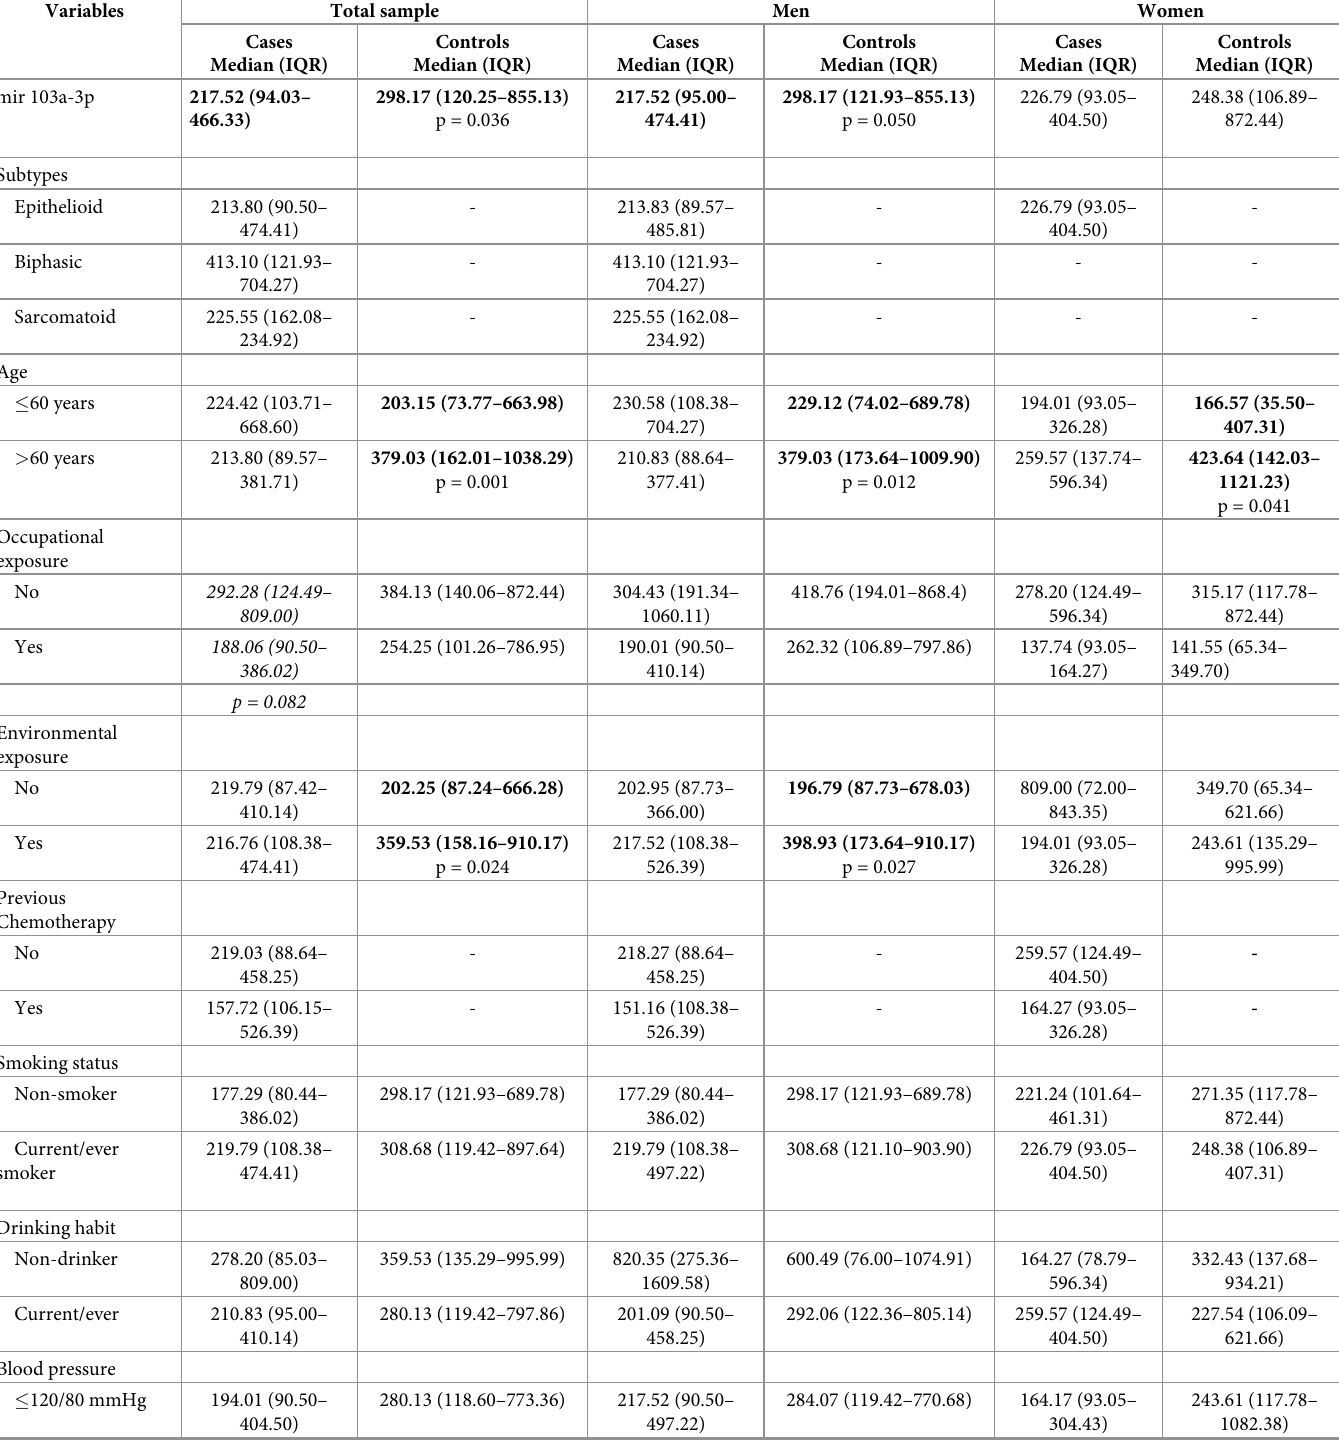
Table 2. Distribution of miR-103a-3p levels in leukocytes among malignant pleural mesothelioma cases and population controls according to sex groups in a Mexi- can